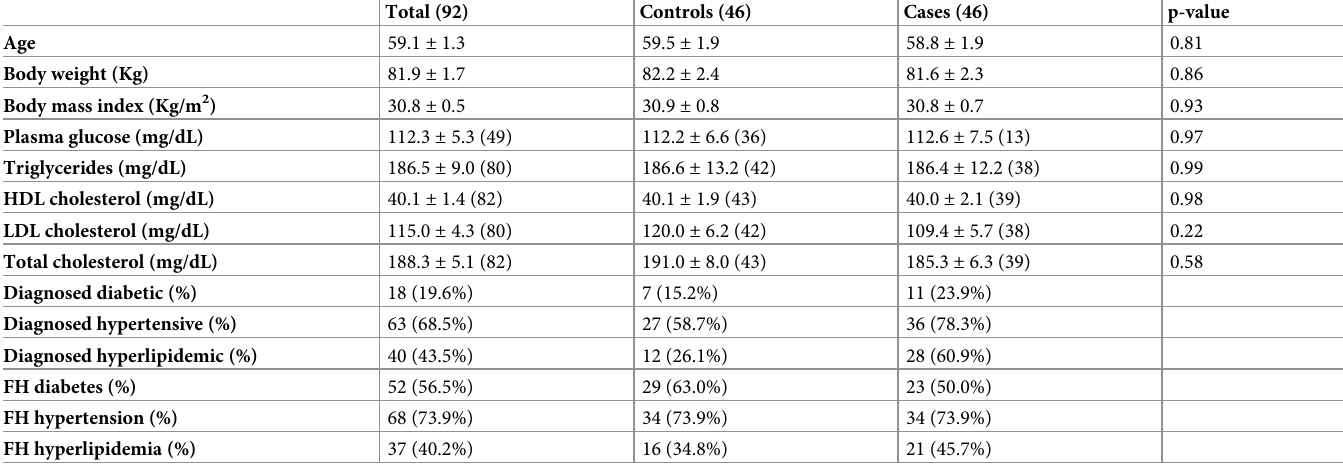
Table 1. Clinical and biochemical features of the 92 subjects selected for presence or absence of aortic valve stenosis.